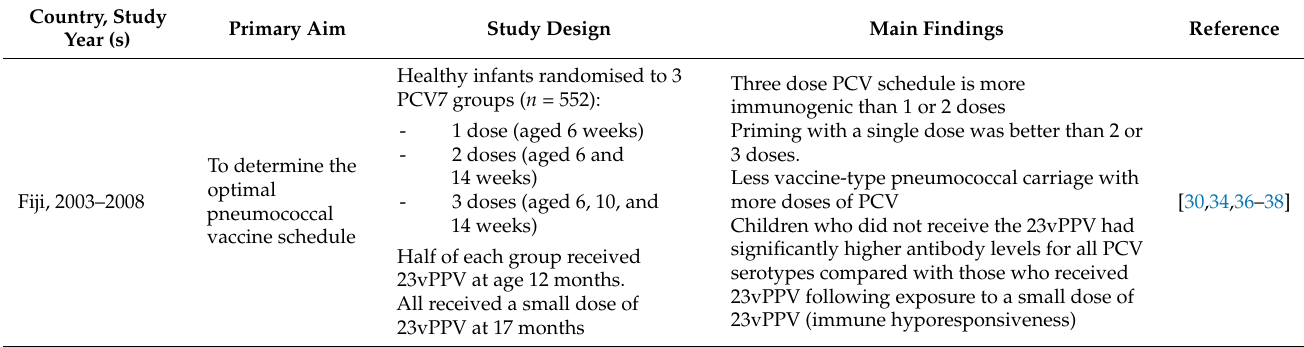
Table 3. Evaluation of alternative pneumococcal vaccine